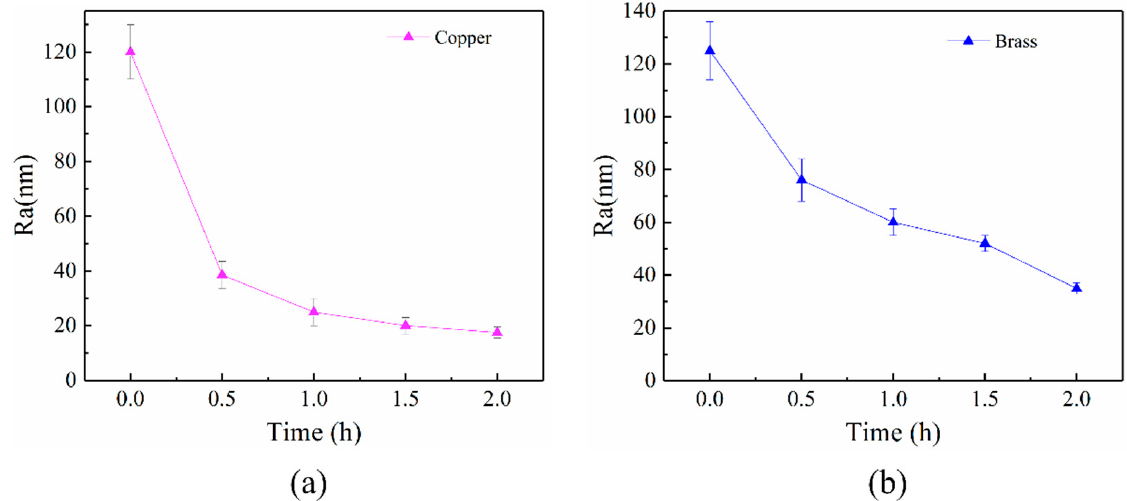
Figure 7. Surface roughness variation of copper workpiece ( a ) and brass workpiece ( b ) polished by alumina-doped titanium dioxide ER polishing fluid (rotation speed = 200 r/min, voltage = 3 kV, machining gap = 0.5 mm).